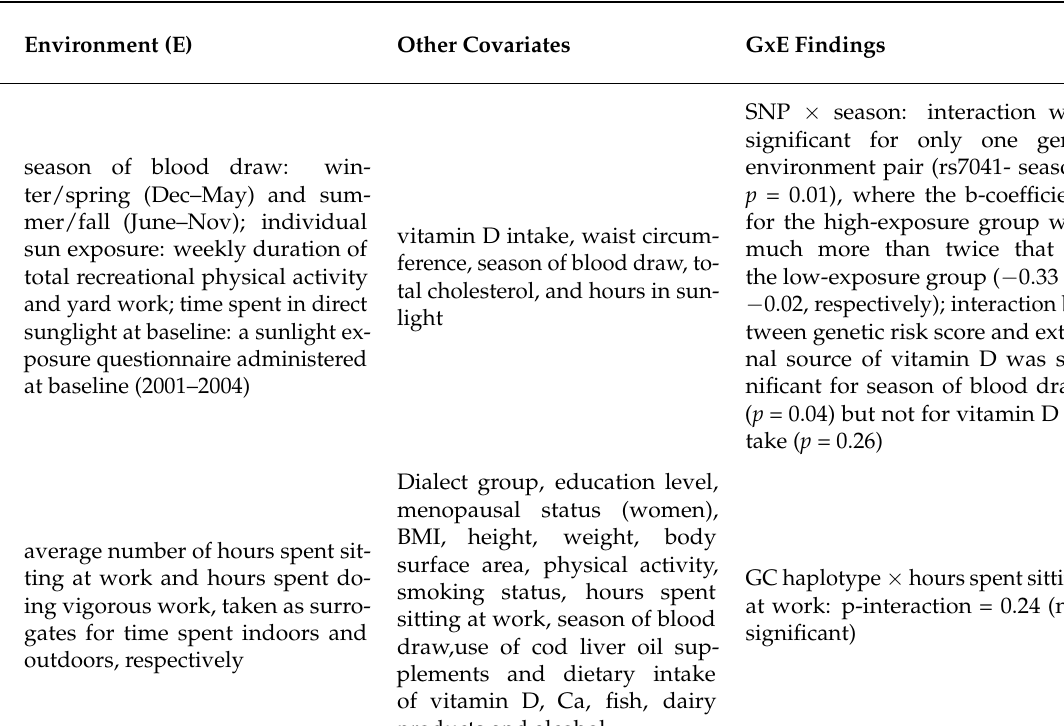
Table 1. Summary of the characteristics of the included studies on gene-environment interactions in vitamin